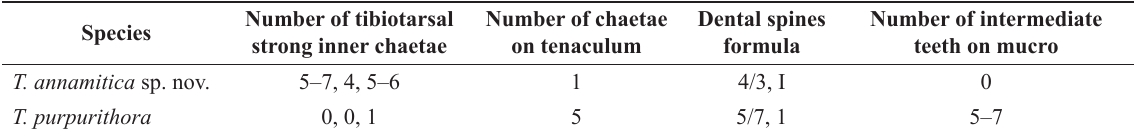
Table 1. Discrimination between Tomocerina annamitica sp. nov. and Tomocerina purpurithora Liu, Hou & Li, 1999